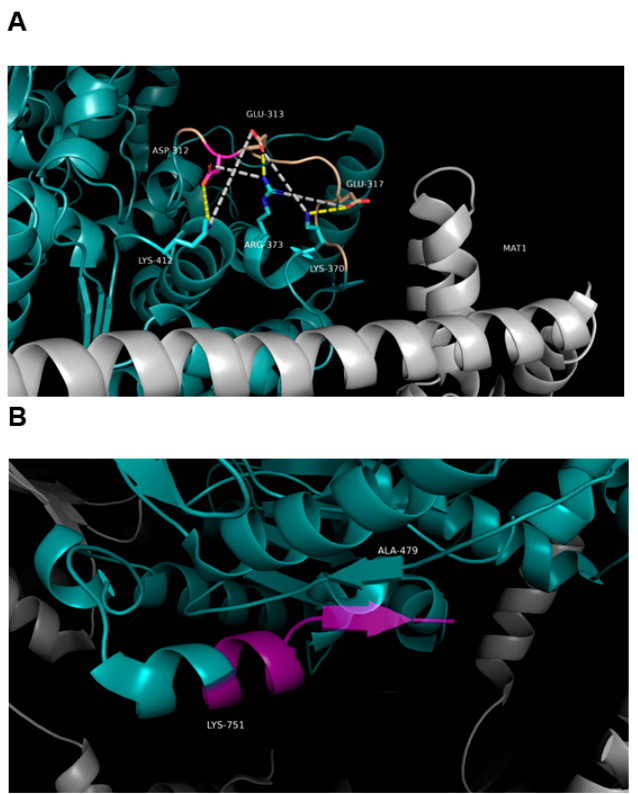
Figure 7. ( A ) Model of the ERCC2 electrostatic interaction network between the negative loop Pro311-Pro320 and positive charges; mutant Asp312Asn (position in magenta) destabilise the interaction and loop. ( B ) Loss of C-terminal α -helix and β -sheet (transparent segment in magenta) following mutation Lys751*.